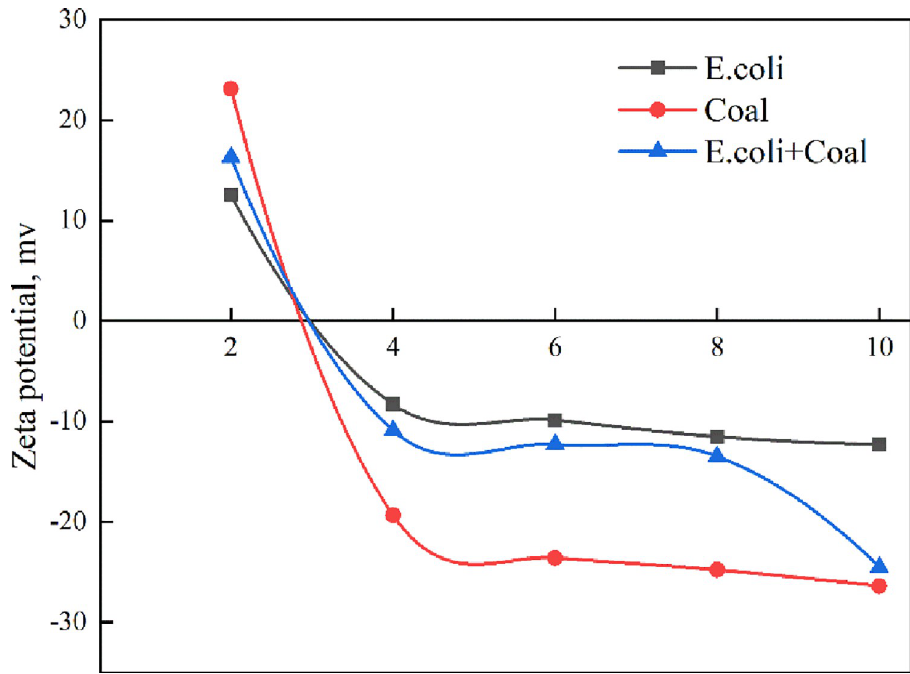
Fig 5. Zeta potential of coal before and after interaction with E . coli as a function of